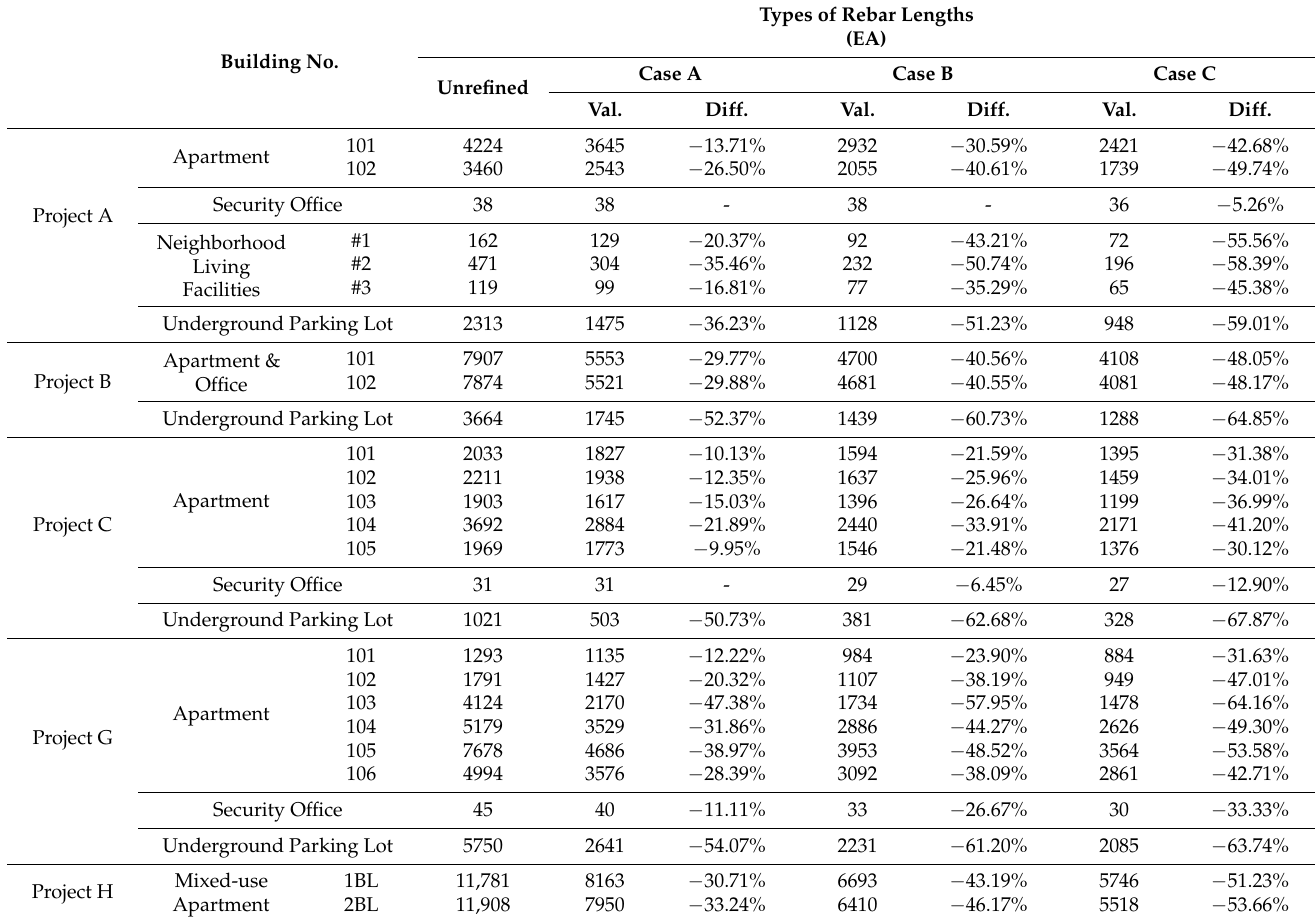
Table A9. Numbers of Rebar LPRS for Slab Members and Differentials by Cases.